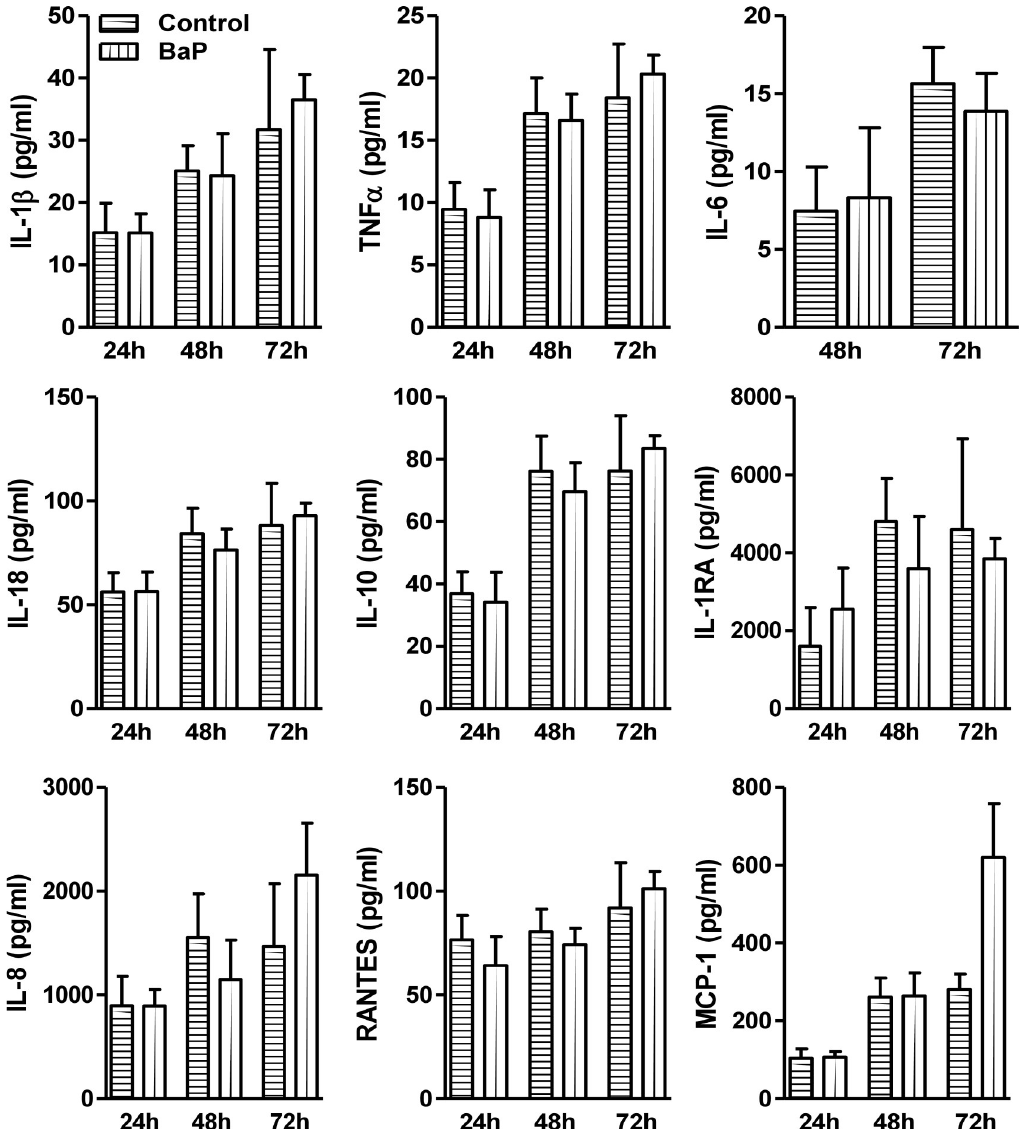
Fig 3. Levels of cytokines and chemokines in BaP-treated U1 cells. Multiplex ELISA analyses of pro-inflammatory cytokine (IL-1 β , TNF α , IL-6, IL-18), anti-inflammatory cytokine (IL-10, IL-1RA), and chemokines (IL-8, RANTES, MCP-1) were performed in U1 cells (at 24, 48, and 72 h) treated with 1 μ M concentration of BaP (daily treatment). Statistical analyses were carried out by using Student’s t-test. Results are expressed as means ± S.E.M of n = 3–4 experiments. changes in the IL-1 β expression at mRNA and protein levels in SVGA cells at different time points. Moreover, we analyzed the mRNA and protein expression levels of AOEs (SOD1 and CAT) and CYP enzymes (CYP2A6, CYP1A1, and CYP1B1), which are known to increase oxi- dative stress upon tobacco exposure, in SVGA cells at different time points (Fig 5A and 5B) after BaP (1 μ M) exposure (Fig 5A–5C). IL-1 β mRNA expression was significantly upregulated in SVGA cells at 24 h (P � 0.001; Student’s t-test; Fig 5A), 48 h (P � 0.001; Student’s t-test; Fig 5A) and 72 h (P � 0.001; Student’s t-test; Fig 5A) post-BaP treatment when compared to untreated cells. Similarly, CYP1A1 and CYP1B1 mRNA expression was also increased after the